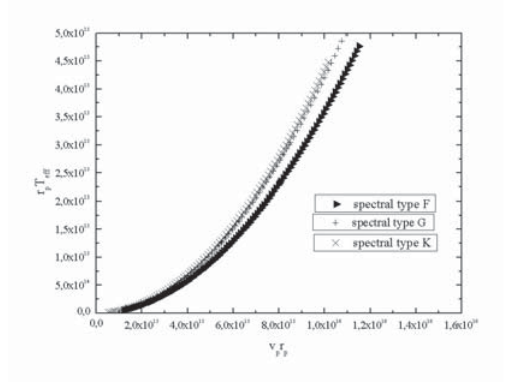
T eq on the v p r p for the p T eq . p